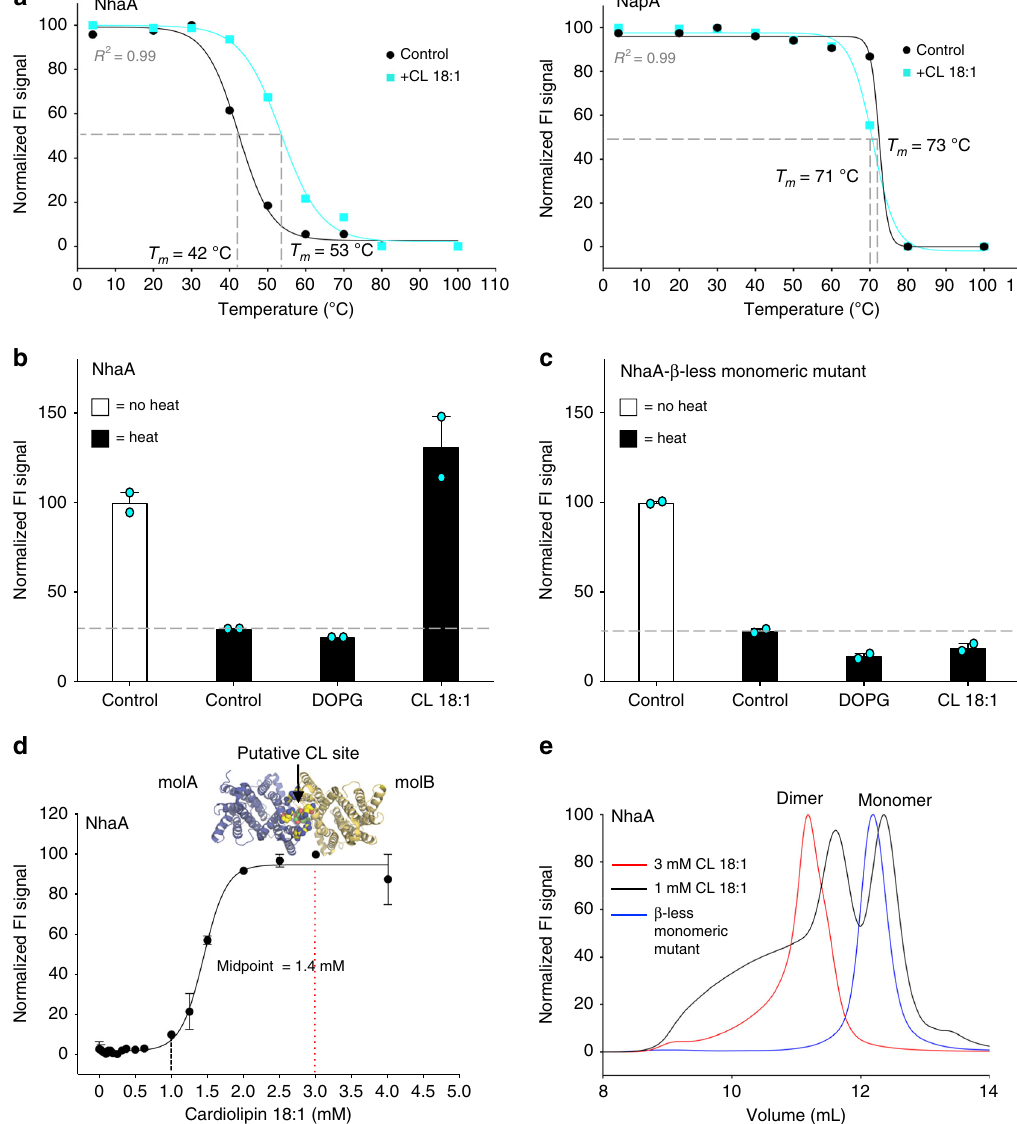
Fig. 1 Validation of FSEC-TS for measuring speci fi c lipid – protein interactions. a FSEC-TS melting curves for the puri fi ed sodium/proton antiporters NhaA- GFP (left) and NapA-GFP (right) in the absence (black) and presence of cardiolipin (CL) (cyan). Apparent T m of crude-detergent solubilized bacterial membrane protein fusions that were determined by the FSEC-TS assay using a range of nine different temperatures that were fi tted to a sigmoidal dose – response equation as described in Methods. Each apparent T m (mean ± s.e.m. of the fi t) is the average from two independent experiments. b FSEC peak fl uorescence of puri fi ed NhaA-GFP before heating (open bars) and that remaining after heating and centrifugation (black bars) in presence of either CL or DOPG; error bars show the range of two technical replicates. c As in b for the monomeric NhaA- β -less mutant. d CL dependent stabilization of NhaA as assessed by FSEC-TS. Black and red lines indicate the preparations shown in e ; inset shows the putative CL binding site between NhaA positively charged promoter surfaces in the dimeric crystal structure (pdb ID 4ATV); n = 3 independent titrations and the error bars show the mean ± s.d of the fi t. e Normalized FSEC-TS traces from the CL titration to NhaA shown in d with either 1 mM CL (black) or 3 mM CL (red), and the NhaA- β -less monomeric mutant